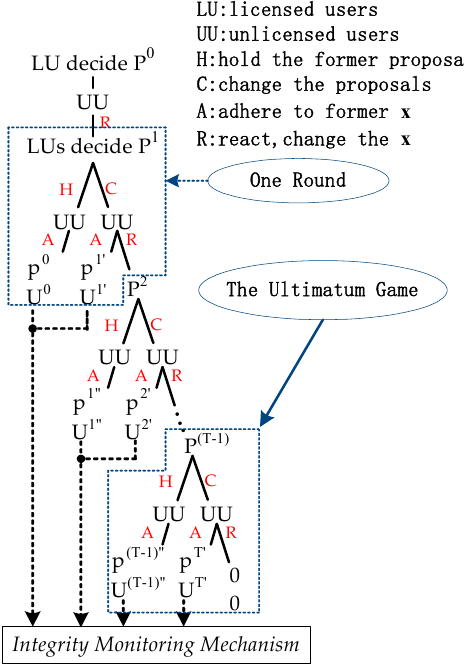
Figure 4. Finitely many rounds of bargaining.